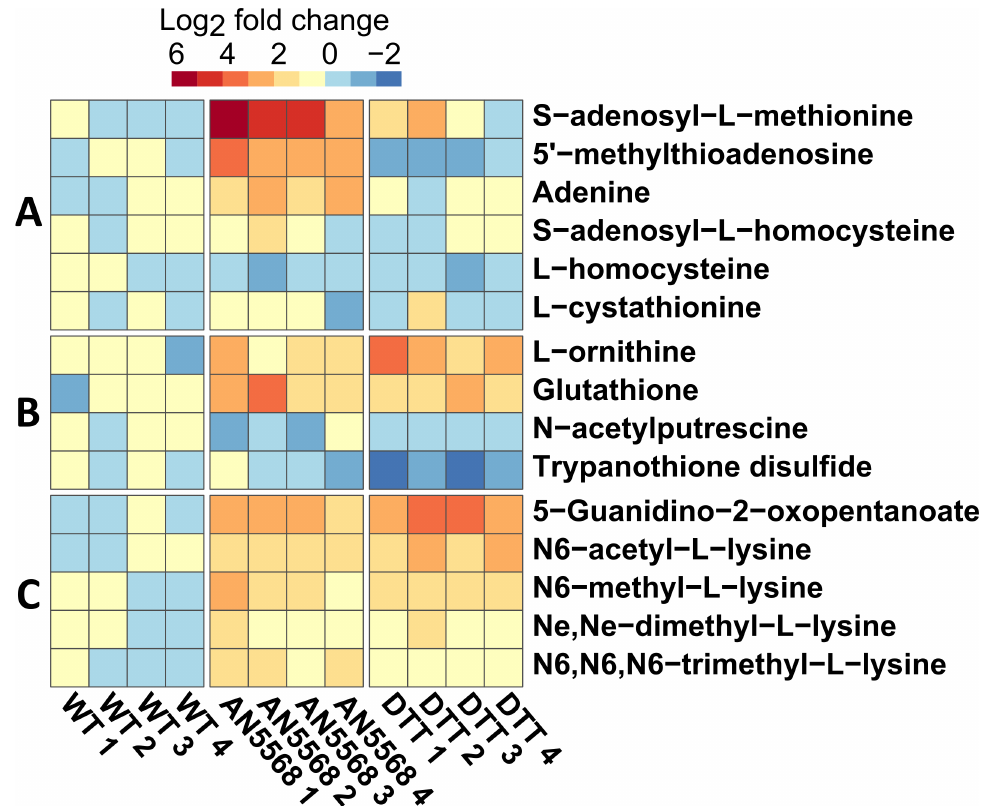
Fig 6. Comparing metabolic profiles of DTT and AN5568 treated cells. A heatmap was generated to highlight similarities and differences in metabolism after treatment with the ER stress inducer dithiothreitol (DTT) and AN5568. A) AdoMet metabolism was unaffected by DTT-treatment. B) Components of the oxidative stress response pathway were altered after both treatments. In particular, DTT treatment led to a significant decrease in trypanothione disulphide. C) Both DTT and AN5568 treatment result in increased levels of modified lysines and arginines, suggesting these are part of a conserved trypanosomatid stress response. WT; wild-type untreated, AN5568; wild-type cells treated with AN5568 for 6 hours at 10 × EC 50 , DTT; wild-type cells treated with DTT for 6 hours at 10 × EC 50